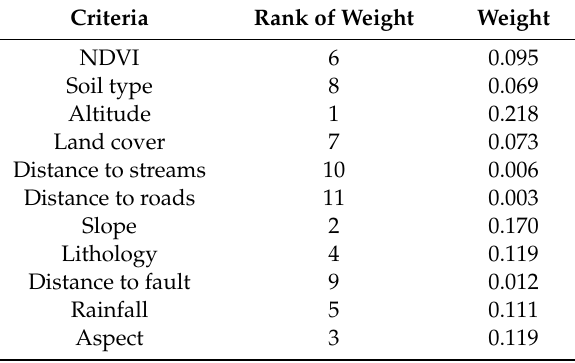
Table 4. The final weight of each criterion from the fuzzy analytic hierarchy process